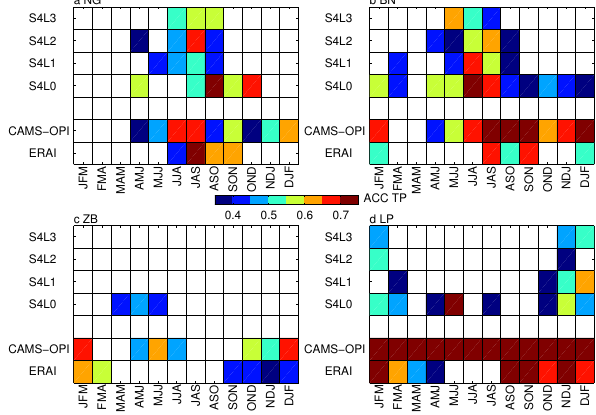
Fig. 6. Anomaly correlation coefficient (ACC) of 3-monthly mean precipitation as a function of verification season (horizontal axis) and dataset (EI: ERAI; CS: CAMS-OPI) and S4 lead time. For example, the colour associated with column OND of line ERAI corresponds to the ACC of ERAI versus GPCP mean October– December precipitation (over 30yr), while the column OND of line SL4L2 corresponds to the ACC of S4 forecasts initialized in August valid for October–December (2 months lead time) compared with October–December precipitation of GPCP. White cells denote sta- tistically insignificant ACC with p > 0.05. The forecast and ERAI and CAMS-OPI are verified against GPCP for the period 1981 to